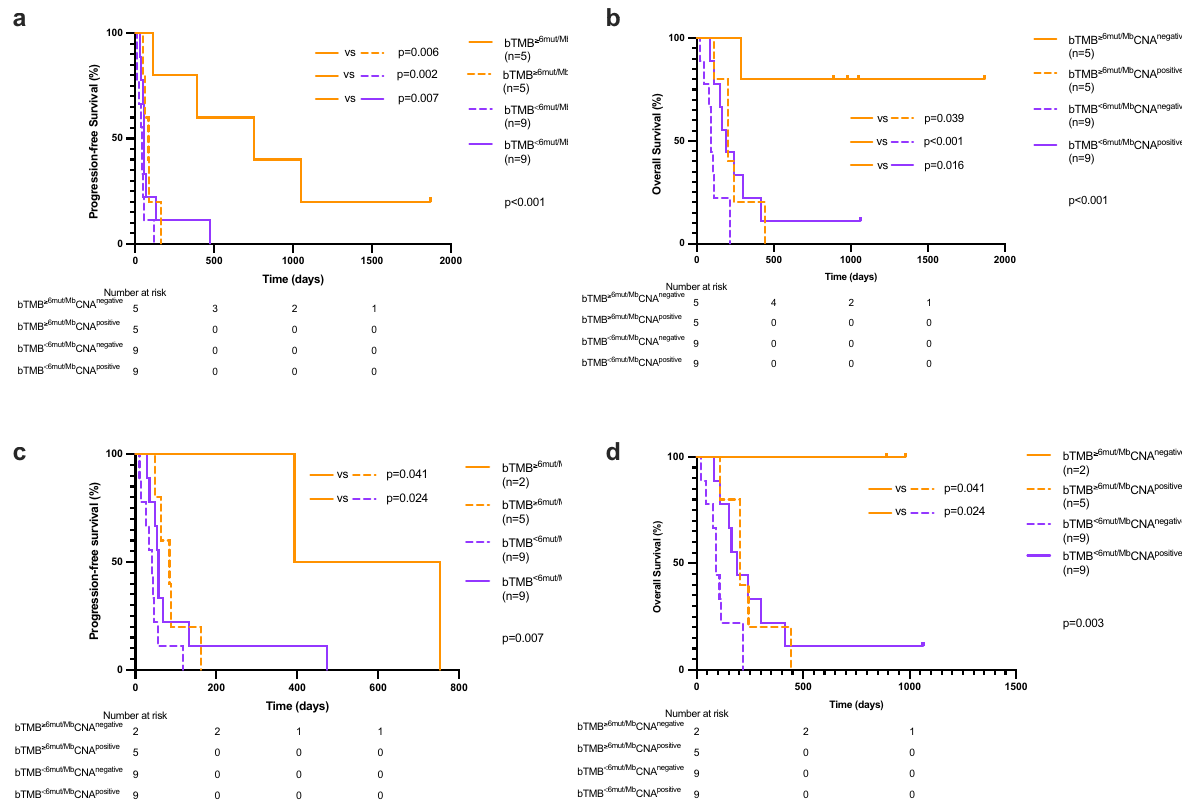
Figure 4. The association of bTMB and CNA combination with clinical outcome of gastric cancer patients treated with nivolumab monotherapy. Kaplan–Meier estimates of progression-free survival (PFS, a ), as well as overall survival (OS, b ) of patients stratified by the combination of bTMB and CNA in the overall population. Kaplan–Meier estimates of PFS ( c ), as well as OS ( d ) of patients stratified by the combination of bTMB and CNA when MSI-H cased excluded. bTMB blood tumor mutation burden, CNA copy number alteration, MSI-H microsatellite instability